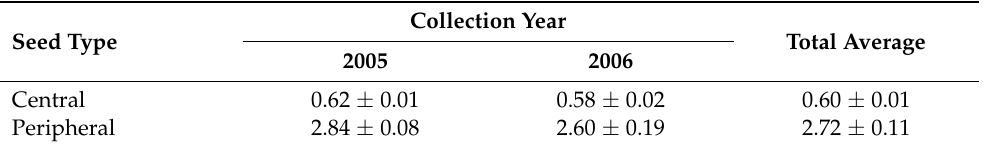
Table 8. Mean values ( ± SE) of seed fresh mass (mg) by seed type and collection year. The central seeds without the pappus but the peripheral ones with the attached phyllaries.